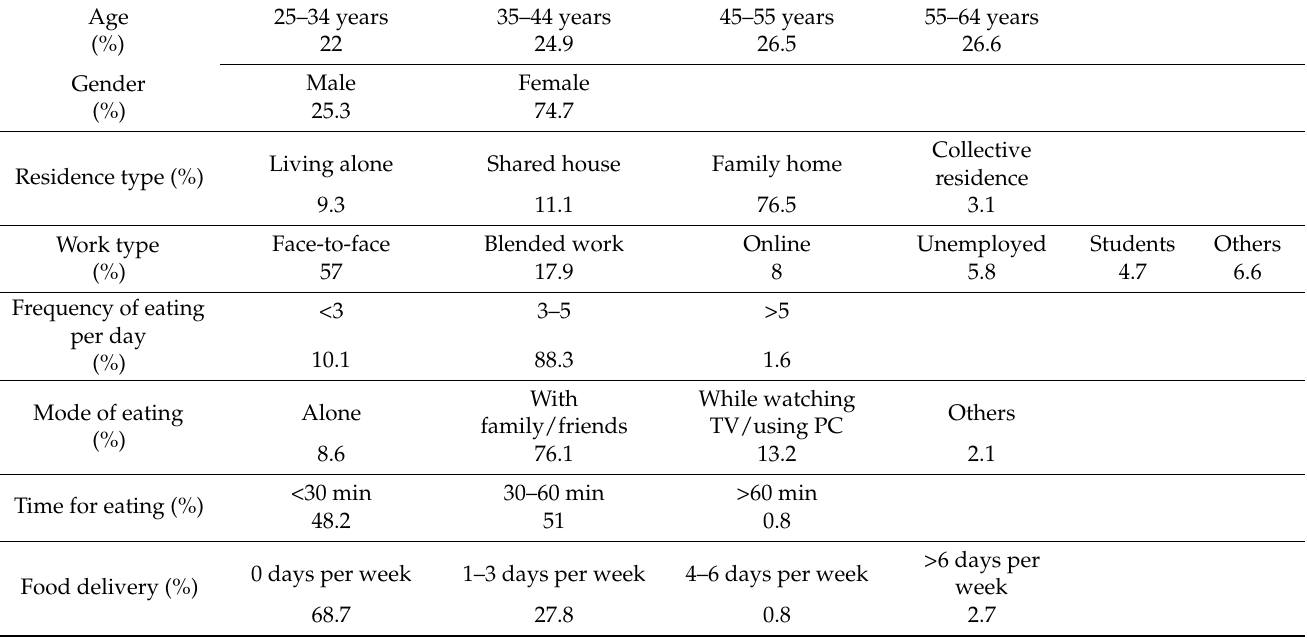
Table 1. Socio-demographic parameters (values are expressed as